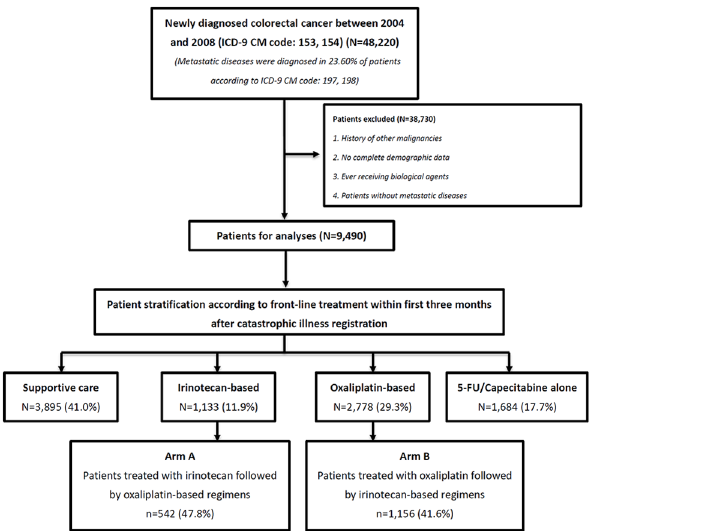
Fig 1. Patient selection and